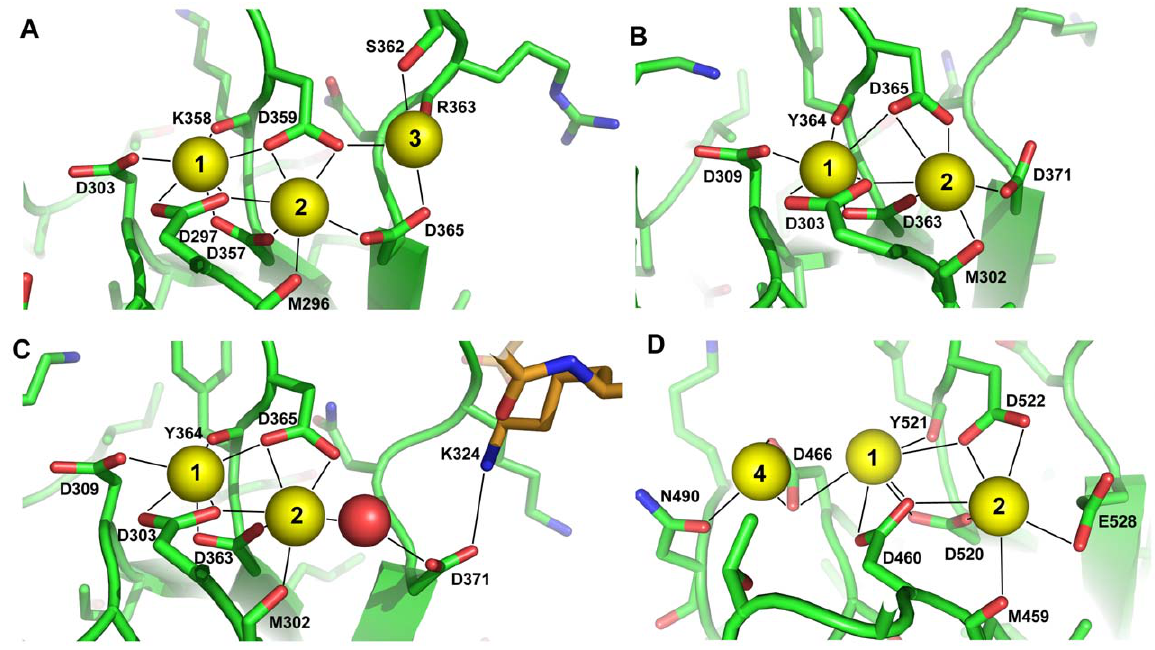
Figure 5. Comparison of the Ca 2 + -binding modes of the C 2 B domains of synaptotagmins-1, -3 and -7. (A) Ribbon diagram showing the Ca 2 + -binding mode of the synaptotagmin-7 C 2 B domain, with the Ca 2 + ligands shown as color-coded stick models (green, carbon; blue, nitrogen; red, oxygen) and the bound Ca 2 + ions shown as yellow spheres. (B) Ribbon diagram showing the Ca 2 + -binding mode of the synaptotagmin-1 C 2 B domain determined by NMR spectroscopy [17] (PDB accession code 1K5W). (C) Ribbon diagram showing the Ca 2 + -binding mode of the synaptotagmin-1 C 2 B domain determined by X-ray crystallography [43] (PDB accession code 1UOW). (D) Ribbon diagram showing the Ca 2 + -binding mode of the synaptotagmin-3 C 2 B domain in the X-ray structure of a synaptotagmin-3 C 2 AB fragment bound to Ca 2 + [47] (PDB accession code 3HN8). The Ca 2 + - binding sites in the different structures are numbered from 1 to 4 according to the nomenclature of ref. [33], with the same numbers used for homologous sites. The color coding in (B–D) is the same as in panel (A), except that in (C) a small portion of a stick model of a second C 2 B domain molecule within the crystal is shown with carbon atoms colored in orange. The side chain of K324 in this region of the second C 2 B domain molecule makes a salt bridge with D371 of the central molecule as a result of crystal packing. A water molecule that coordinates Ca 2 + ion 2 and serves as a bridge with the D371 side chain is shown as a red sphere. Note also that the serine side chain in loop 3 of the synaptotagmin-7 C 2 B domain (S362 panel A) is not present in the synaptotagmins-1 and -3 C 2 B domains (see Figure 2A) and, as a result, Ca 2 + does not bind to site 3 (B,C).